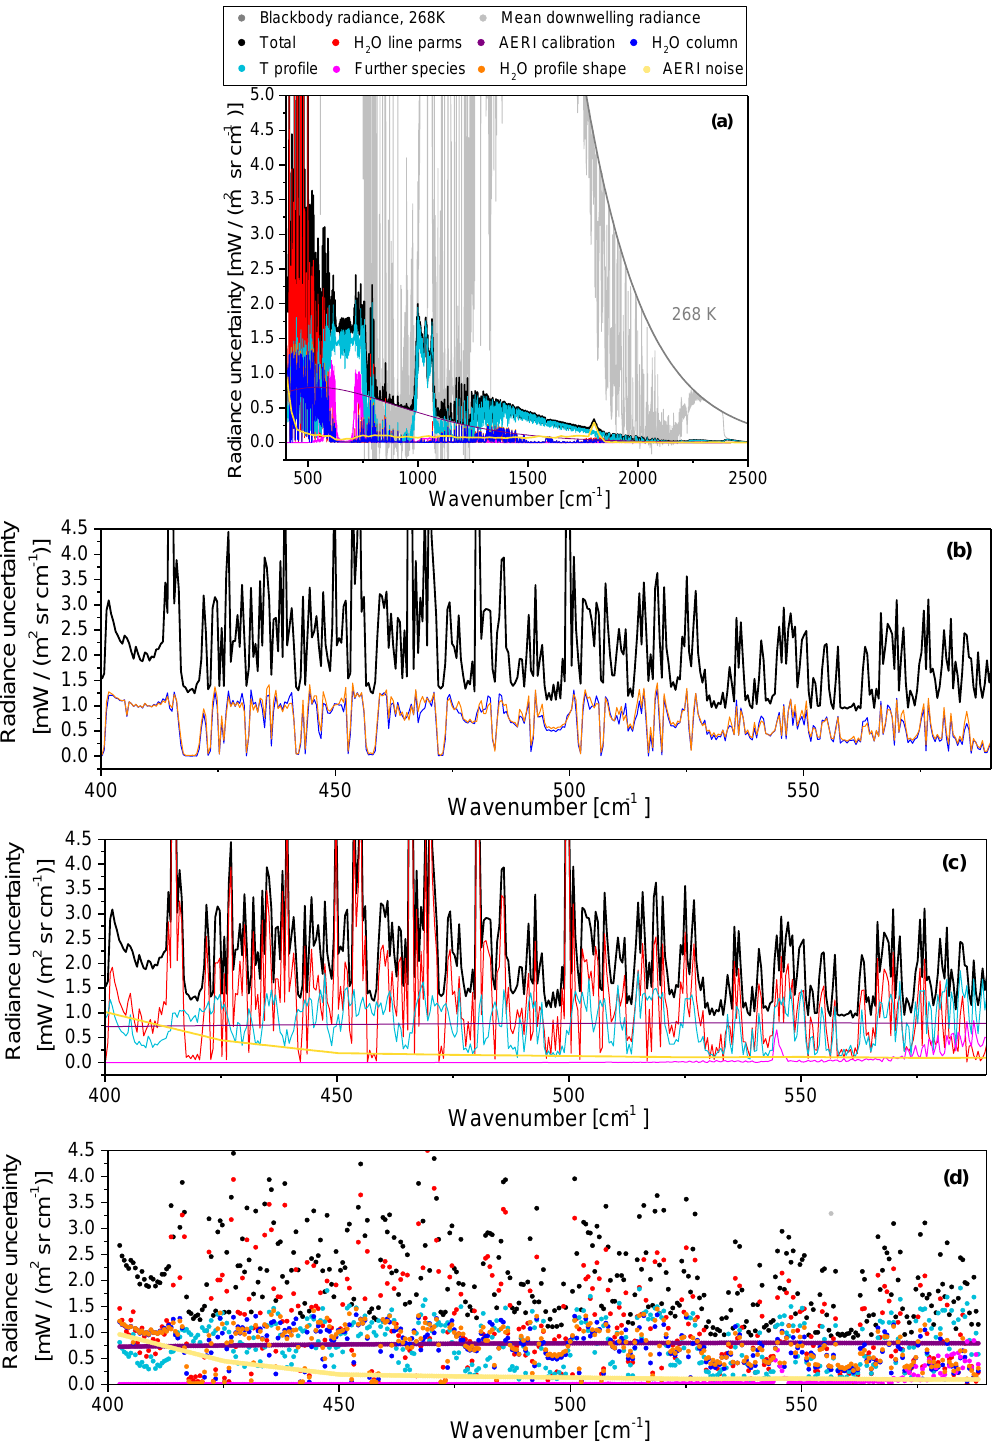
Figure 8. Residual uncertainty (2 σ , relative to ambient BB radiance) of the FIR and MIR closure experiment for a single ER-AERI thermal emission spectrum and for the mean atmospheric state of the closure data set (IWV = 1.6mm; for more details see Sect. 7.1). (a) Individual error contributions (colors; red: “parms” stands for parameters) to the total residual uncertainty (black). For reference, a calculated radiance spectrum (grey) for the mean atmospheric state is shown along with the ambient BB Planck curve. (b, c) Zoom of (a) for the FIR part. (d) Same as (b, c) but restricted to the spectral windows used for continuum